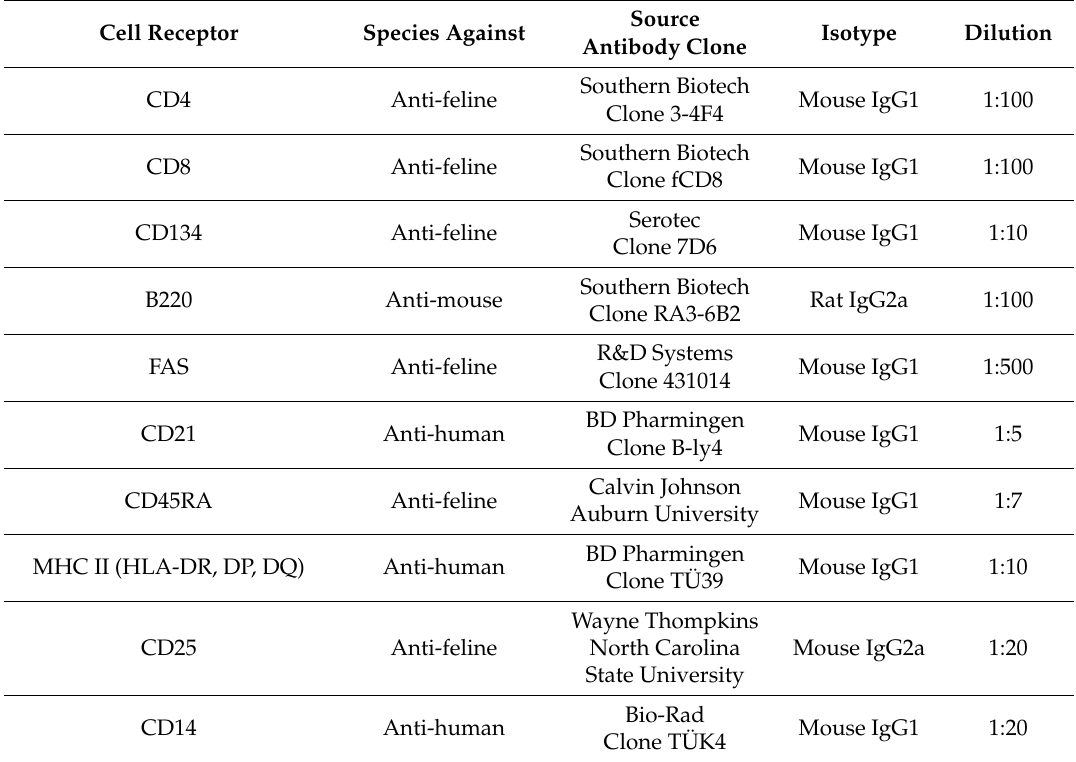
Table 1. Antibodies used for flow cytometry.